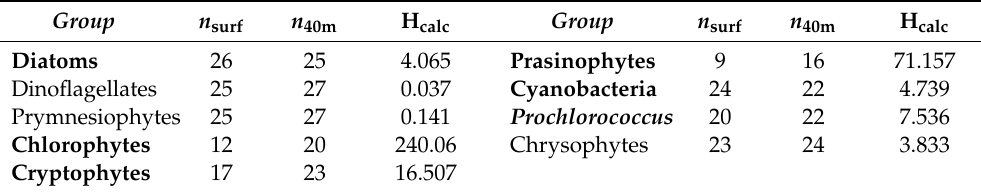
Figure 4. Percentage contribution of each phytoplankton group derived from CHEMTAX at ( a ) surface and ( b ) 40 m depth (or depth of maximum concentration prior to 2008). Black diamonds indicate Chl a (mg m − 3 ) concentration (right axis); in ( a ) the dashed gray line indicates Chl a SAT (mg m − 3 ). Data source for these graphs are shown in Tables S5 and S6 in Supplementary Material. Table 4. Results of the nonparametric Wilcoxon Rank-Sum Test for two independent samples applied to evaluate the significance of the di ff erences in phytoplankton community composition (surface vs. 40 m). Number of data ( n ) and the calculated H (H calc ) are shown for each layer; H calc was compared with H crit = 3.841 ( α = 0.05). Groups with a significant di ff erence between the surface and 40 m (H calc > H crit ) are indicated in bold.